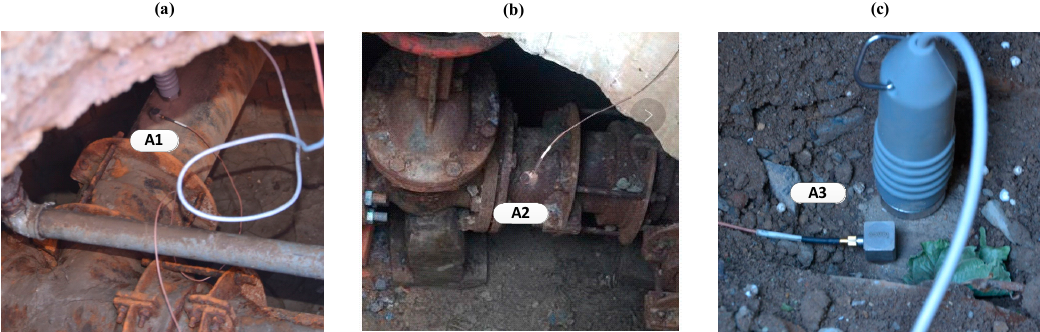
Figure 10. Accelerometers attached magnetically to the test pipe. ( a ) At access point 1; ( b ) At access point 2; ( c ) At access point 3.